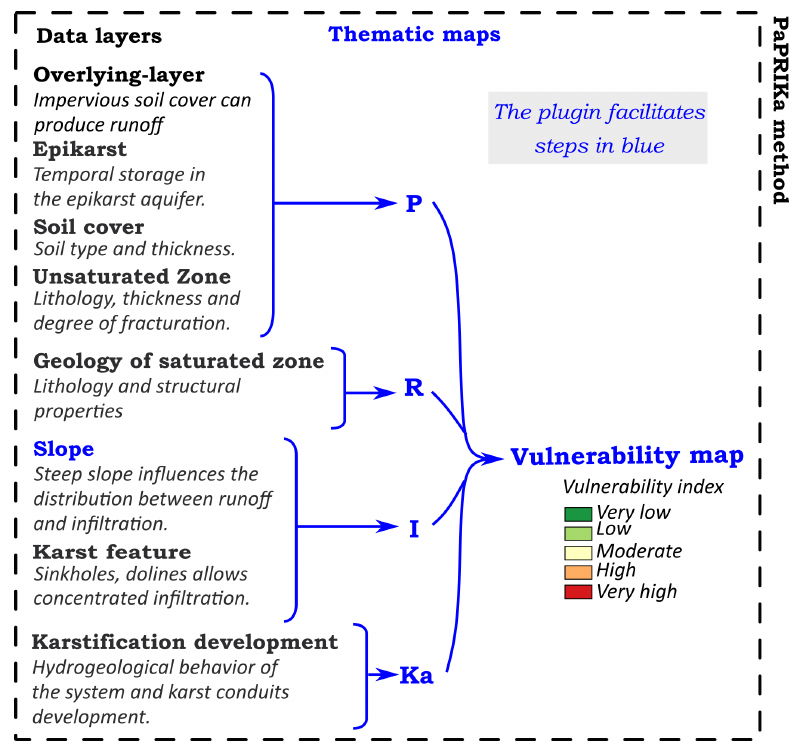
Figure 4. Protection of aquifers: protection, rock type infiltration karstification (PaPRIKa) plugin with detailed datasets in [13].